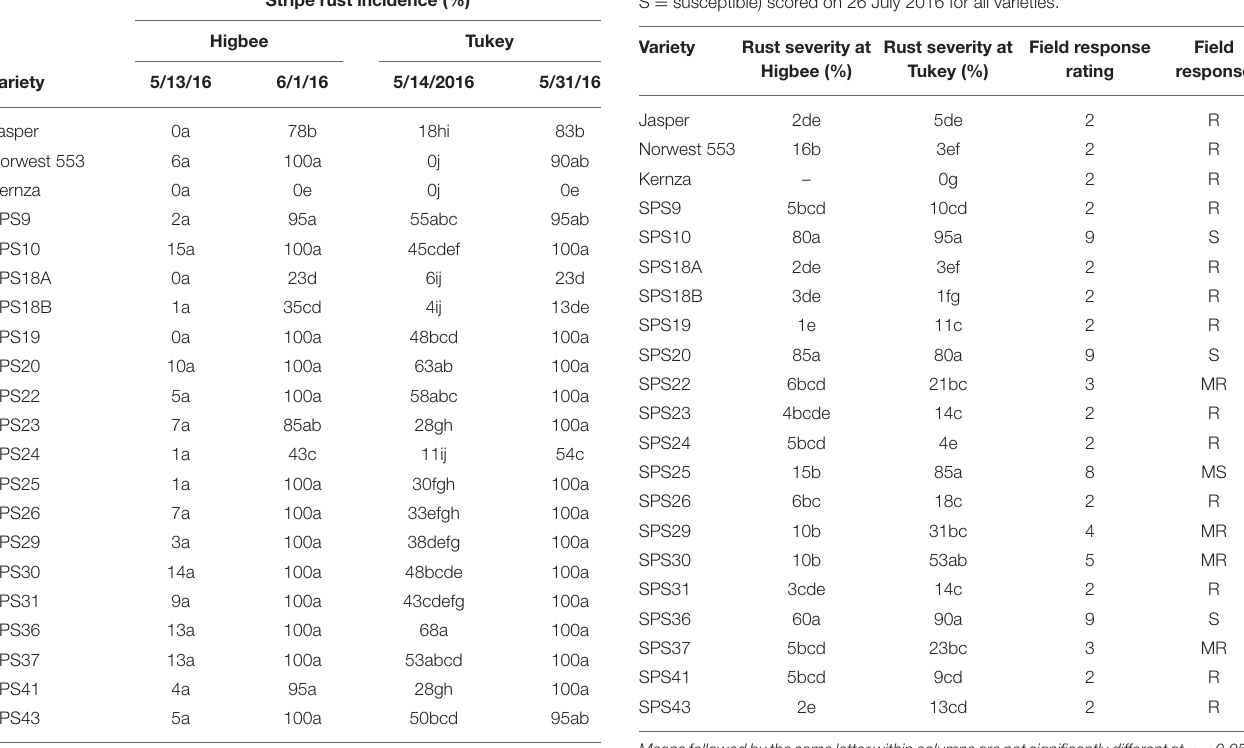
TABLE 6 | Mean stripe rust severity (%), stripe rust field response rating (1 = no TABLE 5 | Mean stripe rust incidence (%) across both locations (Higbee and infection, 9 = susceptible), and stripe rust field response assessment Tukey) over two sampling periods for all varieties tested. (R = resistant, MR = moderately resistant, MS = moderately susceptible, Stripe rust incidence (%) S = susceptible) scored on 26 July 2016 for all